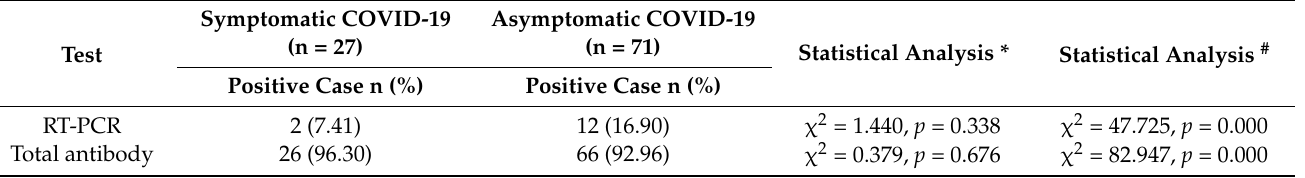
* Comparison of the positive rate of the test in different COVID-19 subgroups. # Comparison of the positive rate of the different tests for COVID-19 subgroups. RT-PCR, reverse-transcriptase quantitative polymerase chain